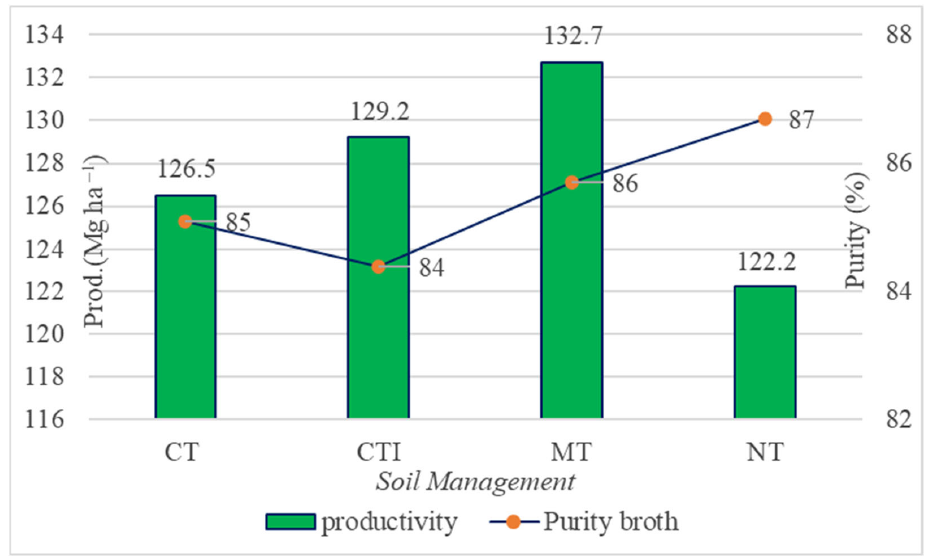
Figure 7. Sugarcane yield and purity of the broth (fresh matter).